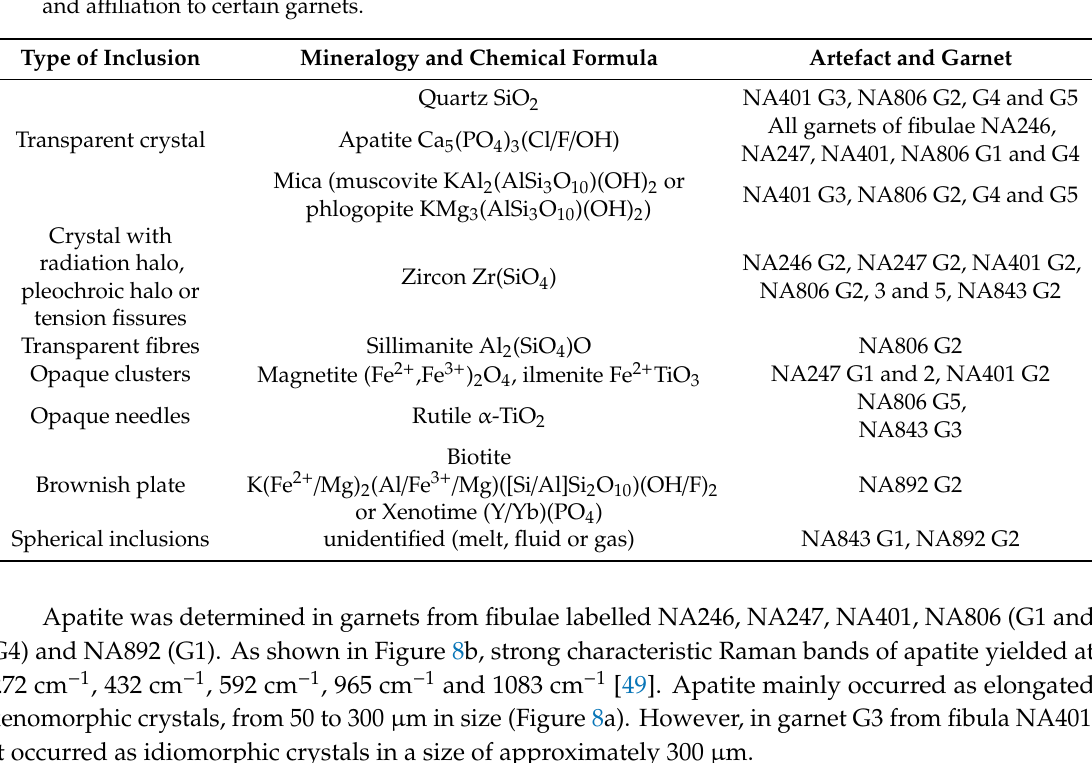
Table 4. Observed inclusions in garnets from S-fibulae, regarding a type of inclusion, their mineralogy and a ffi liation to certain garnets.